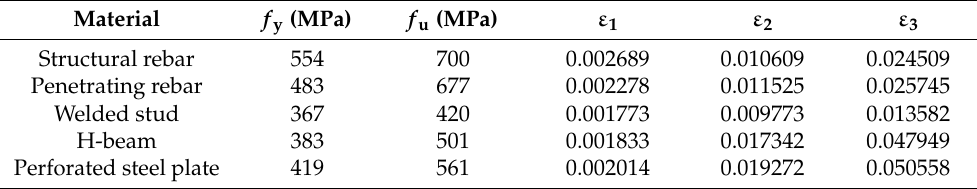
Figure 17. Material constitutive relationships: ( a ) concrete in compression; ( b ) concrete in tension; ( c ) other materials. Table 5. Characteristic point values for other material constitutive